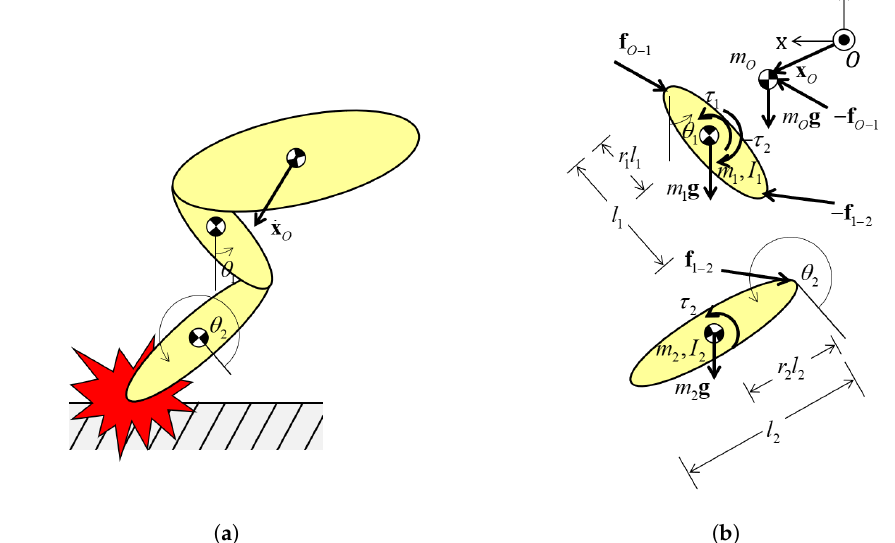
Figure A1. Articulated rigid body dynamics: ( a ) impact; ( b ) free body